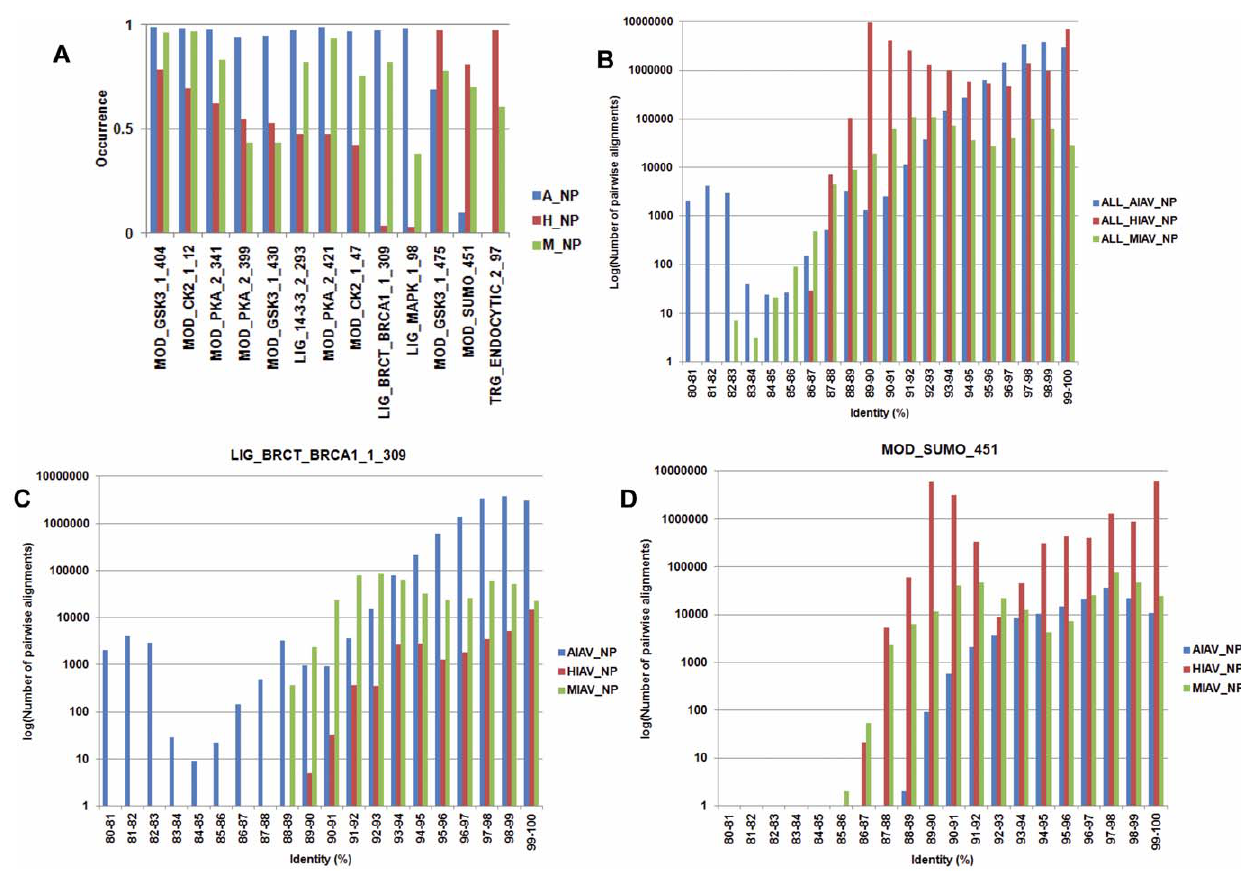
Figure 5. SLiMs from IAV NP proteins that have a differential occurrence in IAVs from different hosts. (A) 13 SLiMs that have a differential occurrence in IAV NP proteins from different hosts. A_NP, H_NP and M_NP indicate the NP proteins from avian, human and IAV, respectively. The Y-axis indicates the occurrence of each identified SLiM. The X-axis indicates the name and position of each identified SLiM in the NP proteins. For example, ‘‘MOD_SUMO’’ in ‘‘MOD_SUMO_451’’ is the name of the SLiM, and 451 is the amino acid position where the SLiM starts. (B) The distribution of pairwise alignment identity of all NP protein sequences from avian, human and mammalian IAVs. (C) The distribution of pairwise alignment identity of NP protein sequences which harbor the SLiM LIG_BRCT_BRCA1_1_309 from avian, human and mammalian IAVs. (D) The distribution of pairwise alignment identity of NP protein sequences which harbor the SLiM MOD_SUMO_451 from avian, human and mammalian IAVs. For B, C and D, the X-axis indicates the number of pairwise alignments of IAV NP protein sequences. The Y-axis indicates the identity of pairwise alignment (the percentage of identical amino acids that are the same in both NP sequences). Blue: NP protein sequences from avian IAVs. Red: NP protein sequences from human IAVs. Green: NP protein sequences from mammalian